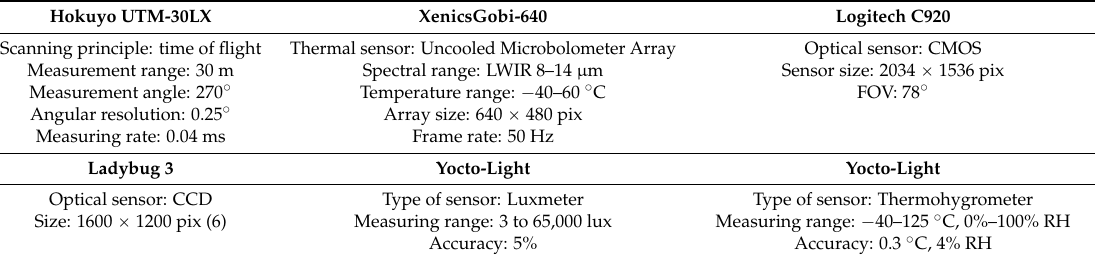
Table 1. Technical characteristics of the sensors installed on the IMAS.